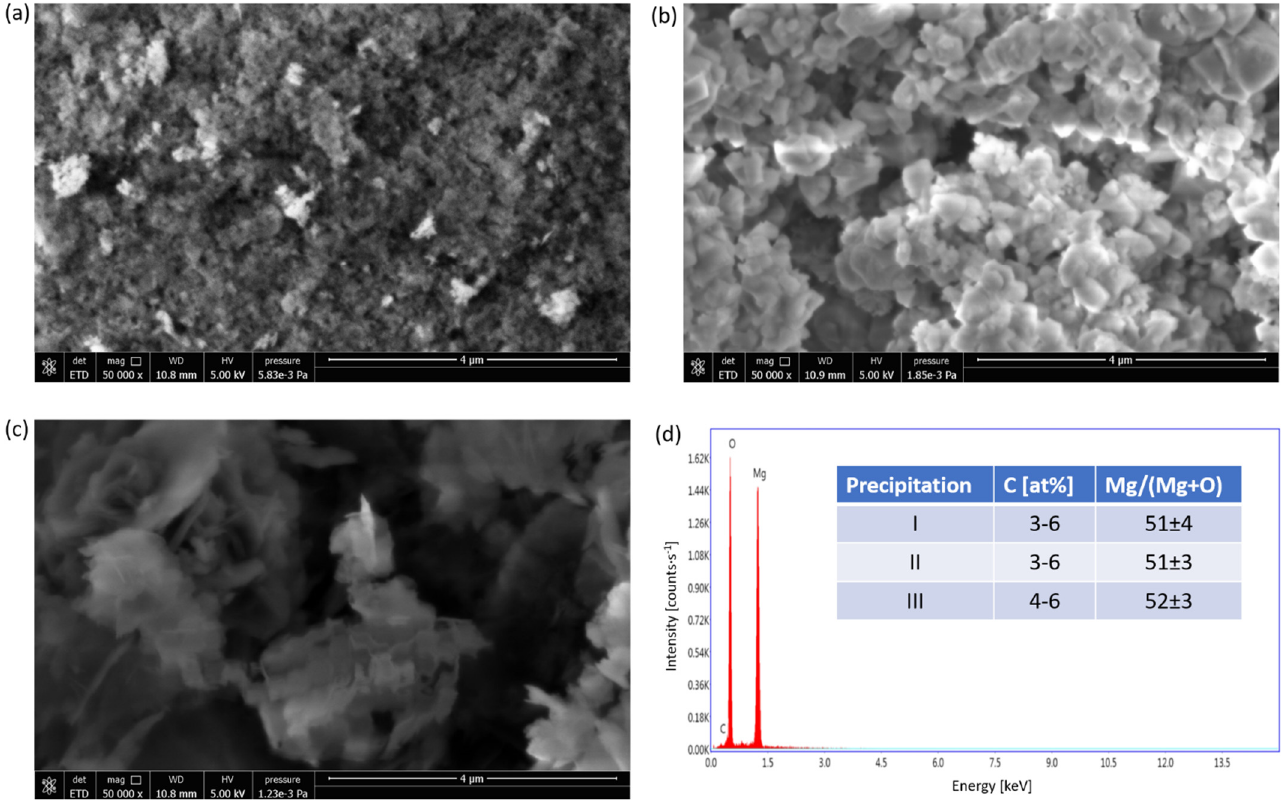
Figure 6. SEM and EDX results: images with 50,000 times magnification of MgO obtained from the ( a ) first, ( b ) second, and ( c ) third fraction, and ( d ) typical EDX result; inset: numerical data for the precipitates.